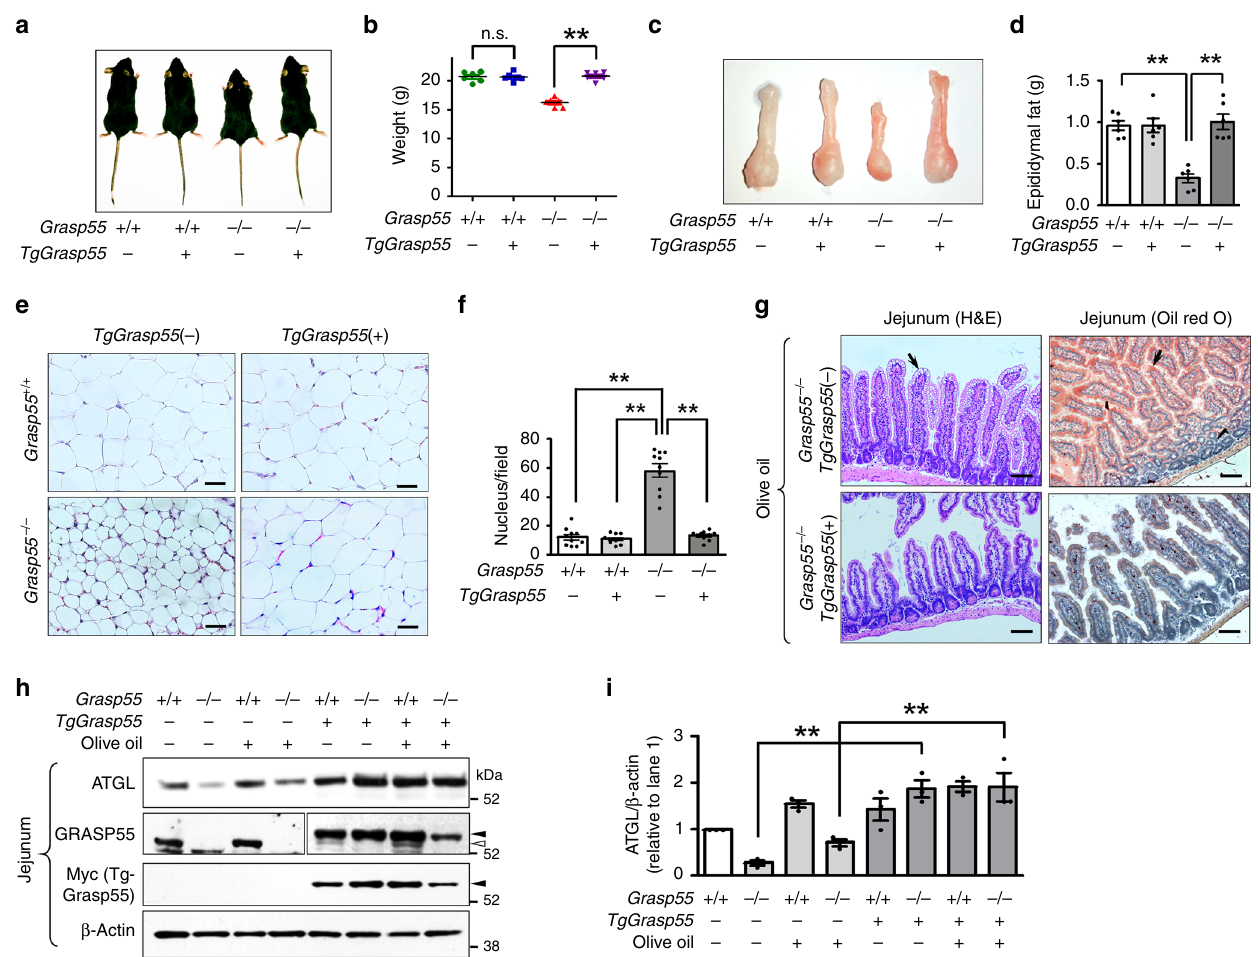
Fig. 9 GRASP55 de fi ciency-induced lipid storage defects are rescued by supplementation of GRASP55 in mice. Wild-type ( Grasp55 + / + ) and Grasp55 − / − mice were crossed with transgenic mice overexpressing GRASP55-Myc ( TgGrasp55 ). a , b Photographs ( a ) and a summary of body weight ( b , n = 6) of 12-week-old male mice. c , d Photographs ( c ) and a summary of weight ( d , n = 6) of epididymal white adipose tissues (EWAT, right side). e , f Representative light microscopic images (H&E) of EWAT are shown in ( e ). Quantitative analyses of the H&E images, that inversely correlate with fat contents of EWAT by counting the number of adipocyte nuclei in a light microscopic fi eld (450 × 340 μ m), are presented in ( f , n = 6). g H&E and Oil Red O staining of mouse jejunum 4 h after olive oil bolus (10 μ l g − 1 body weight). TgGrasp55 ( + ) reduced the postprandial lipid accumulation of jejunal epithelia in Grasp55 − / − mice. Arrows indicate supersized LDs. h , i The protein amount ATGL of mouse jejunum was analyzed by immunoblotting. Representative immunoblots are shown in ( h ). In some experiments, jejunum tissues were prepared 4 h after olive oil bolus (10 μ l g − 1 body weight). The fi lled arrowhead and open arrowhead indicate levels of the exogenous GRASP55-Myc and endogenous GRASP55, respectively. A blot with a longer exposure time of GRASP55 is shown in the left four lanes to better visualize the presence and absence of endogenous GRASP55. The results of multiple experiments ( n = 4) are summarized in ( i ). TgGrasp55 ( + ) increases the protein levels of ATGL in jejunal epithelia of Grasp55 − / − mice. Unprocessed blots can be found in Supplementary Fig. 22. Data are shown as mean ± SEM. Scale bars: 50 μ m. n.s.: not signi fi cant, ** p < 0.01. P values were calculated by unpaired